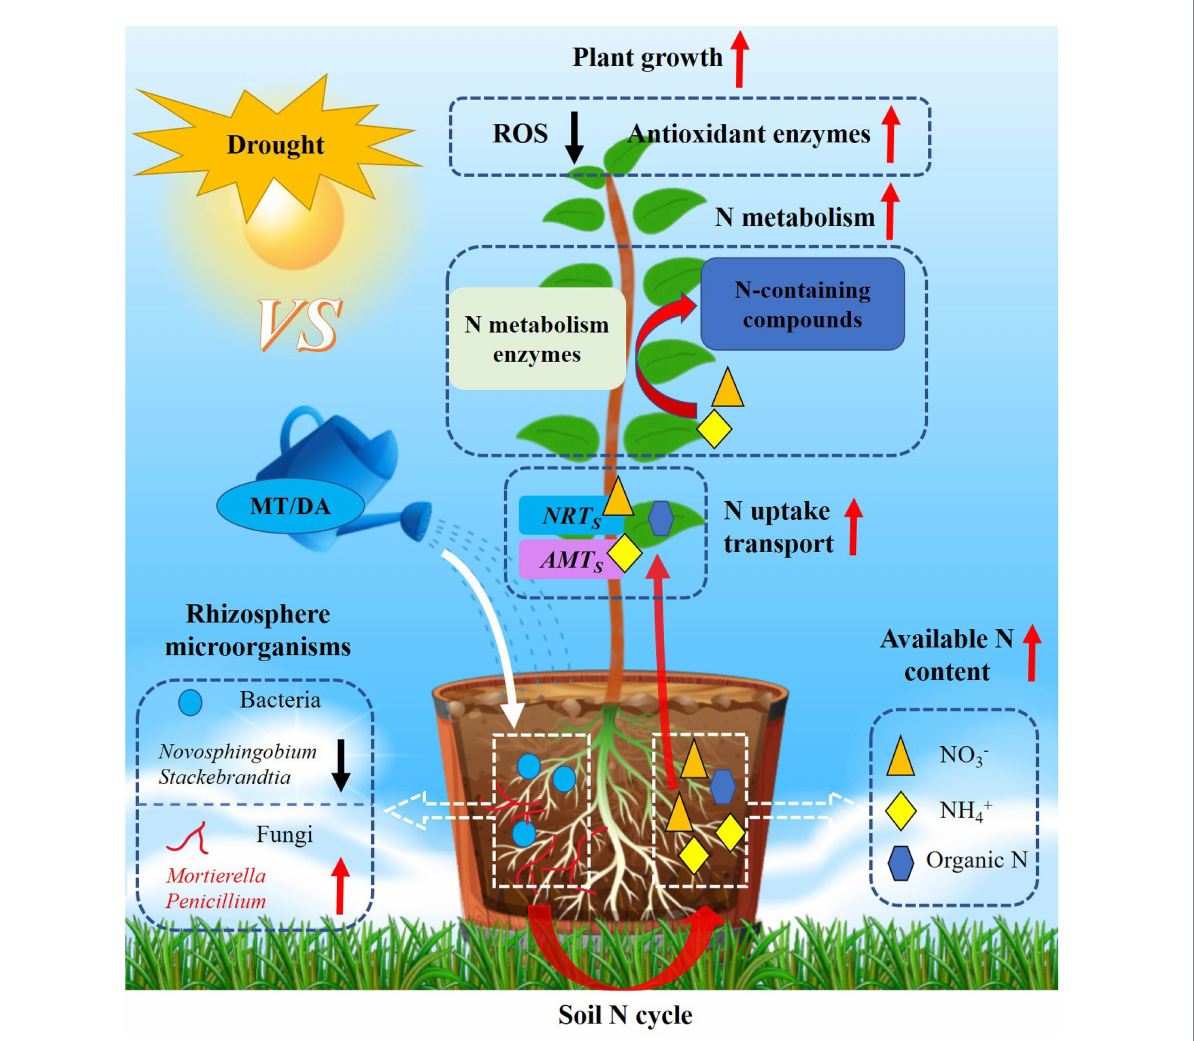
FIGURE 8 Proposed model for the potential mechanisms of melatonin and dopamine mitigation of drought stress. Under drought conditions, melatonin and dopamine applied in soil can enhance plant drought tolerance by removing reactive oxygen species, promoting N absorption and utilization, and changing the composition of rhizosphere microbial community. Melatonin and dopamine can exert positive (red arrow) and negative (black arrow) effect on a variety of plant and soil